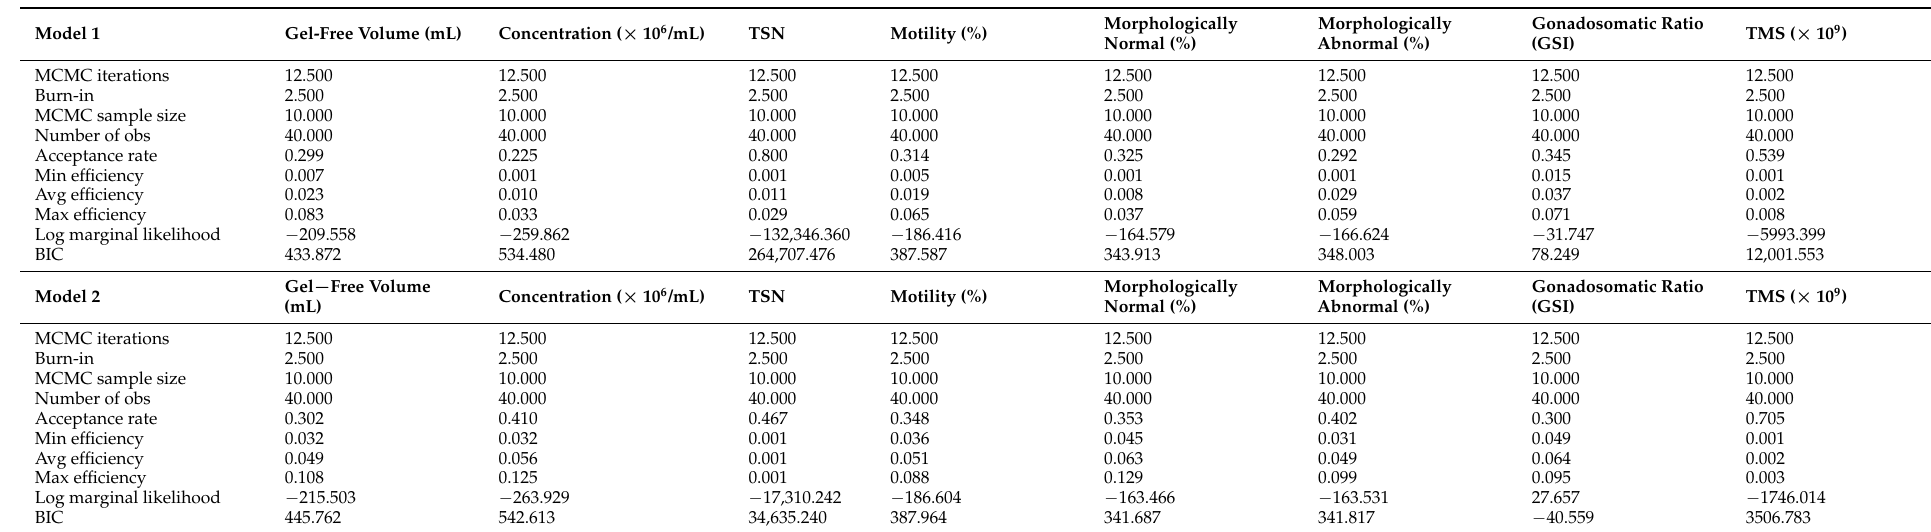
Table 8. Model validity